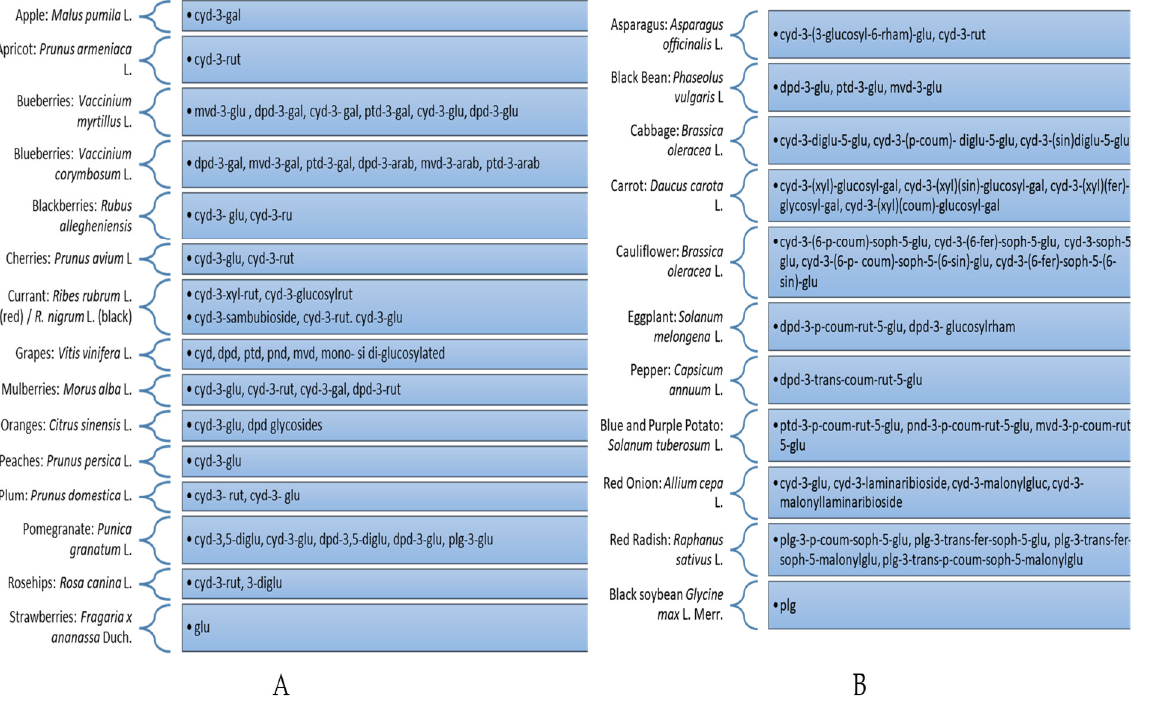
Figure 2. Majority of anthocyanin compounds in various fruits ( A ) and vegetables ( B ) [2] Note: cyanidin—cyd; delphinidin—dpd; petunidin—ptd; peonidin—pnd; pelargonidin—plg; malvidin— mvd; glu—glucoside; gal—galactoside; arabinoside—arab; rutinoside—rut; caffeoyl—caf; xylosyl— xyl; sinapoil—sin; feruloyl—fer; coumaroyl—coum; phenol—phen; p-hydroxybenzoyl—hydbenz; sophoroside—soph; rhamnosyl—rham.